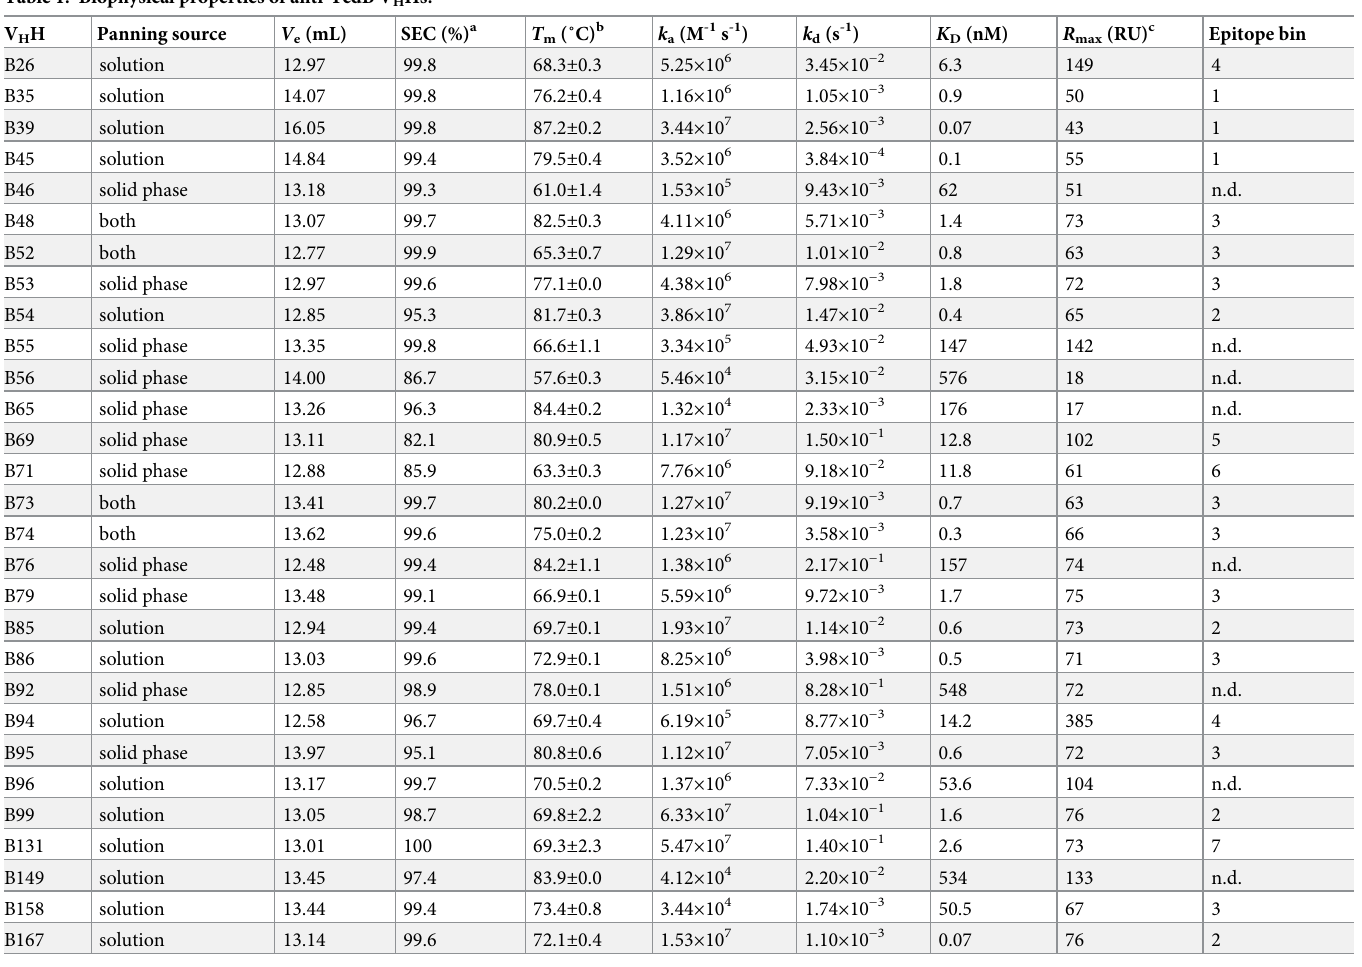
Table 1. Biophysical properties of anti-TcdB V H